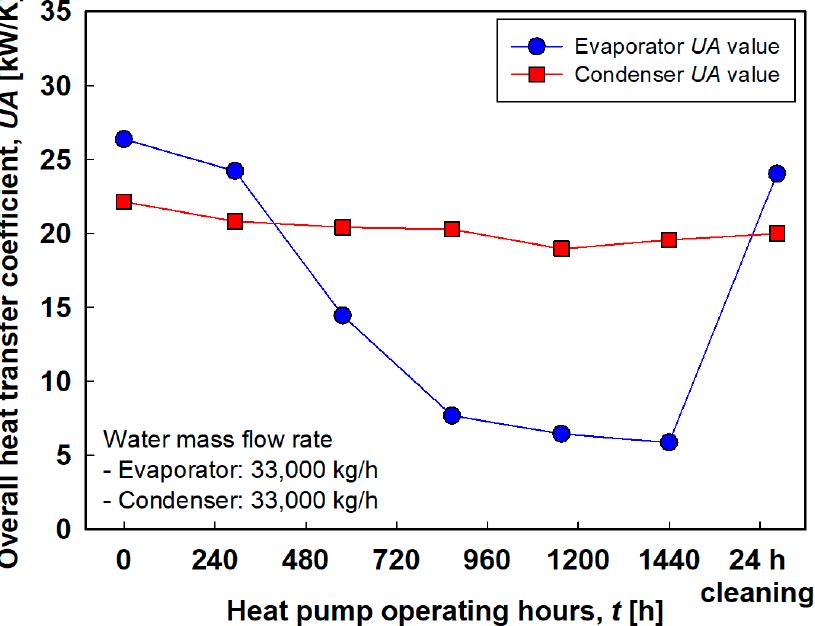
Figure 12. Variation of overall heat transfer coefficient according to heat pump operating hours.